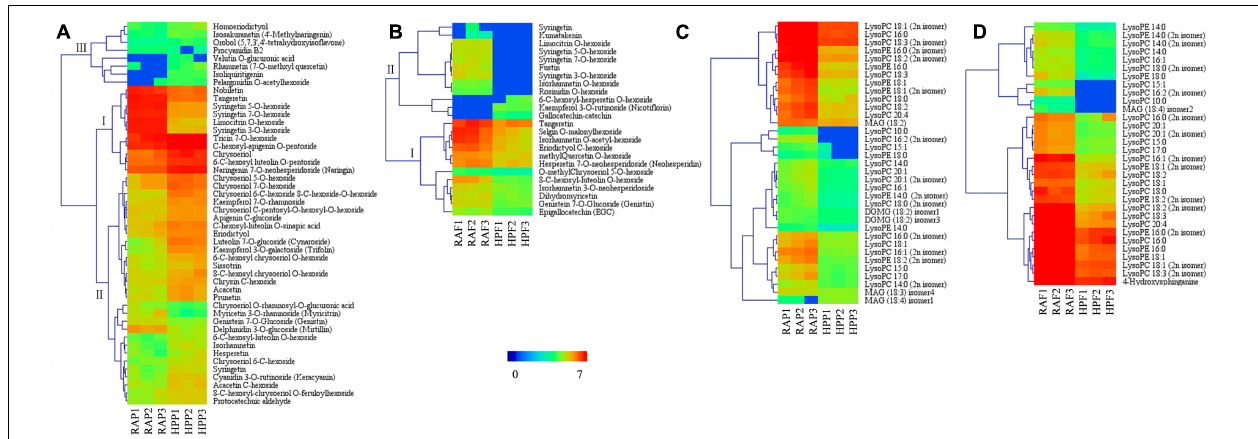
FIGURE 4 | Heat map visualization of the relative differences in flavonoids and lipids in the peel and flesh of HP compared with those of RA. (A) Flavonoids in the peel and (B) in the flesh. (C) Lipids in the peel and (D) in the flesh. The content of each metabolite was logarithm-normalized to complete linkage hierarchical clustering. Each column represents one sample, and each single row represents one metabolite. Red to dark blue indicates abundance changes from high to low.